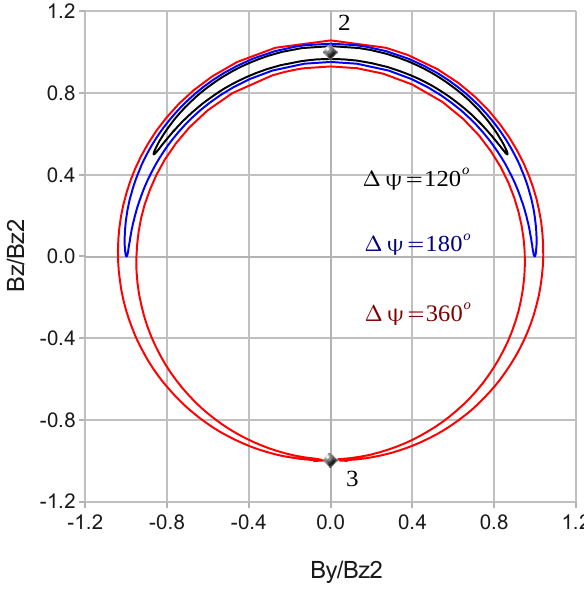
= 1 . 001, β = 1, γ = 2, and Fig. 1. Hodogram traces for A 2 2 x 2 sin 2 θ 2 = 0 . 996 and with three values of the net rotation angle, 19 = 2 9 ∗ , of the tangential field. Fixed Point 2 ( a “center”) is at the center of the nest of traces ( B y /B z2 = 0 ; B z /B z2 = 1); Fixed Point 3 (a saddle point) is on the negative B z -axis, at the bottom of the plot, where the red curves intersect. (From Sonnerup et al.,